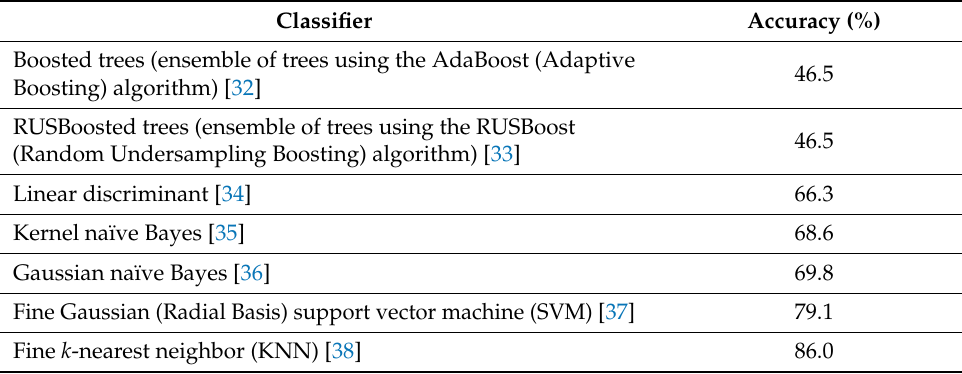
Table 2. All tested classifiers ranked in terms of accuracy (%). Classifier Accuracy (%) Boosted trees (ensemble of trees using the AdaBoost